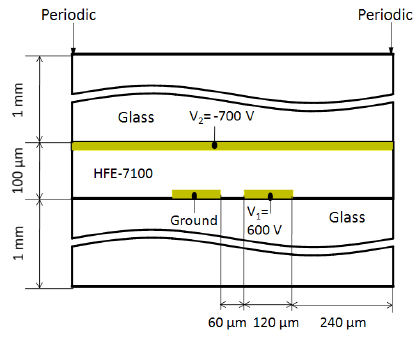
Fig. 16 Power consumption and pump efficiency as a function of flow rate at V = 600 V and V = -700 V 2